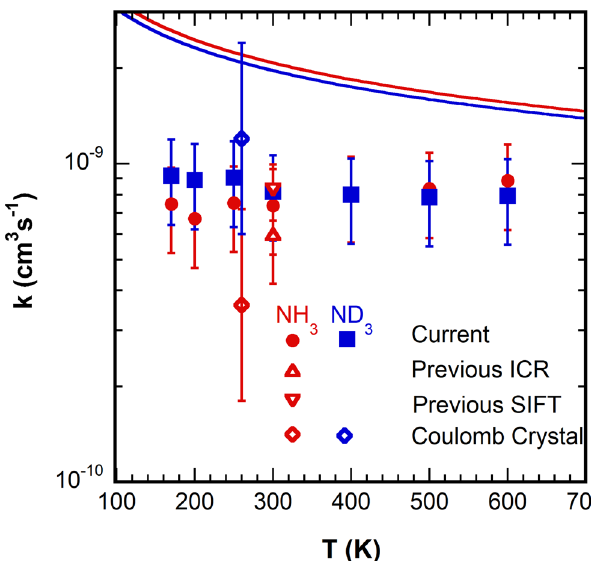
Fig. 1 Comparison of Xe + + NH 3 /ND 3 rate constants. Experimental rate constants for Xe + + NH 3 (red)/ND 3 (blue) as a function of temperature for the present work (solid circles/squares) with error bars indicating the 95% con fi dence region, as well as those previously published (open symbols): Derai et al. (up triangle, ref. 9 ) and Chau and Bowers (up triangle, ref. 10 ), Smith, Adams and co-workers (down triangle, ref. 3,4 ), Petralia et al. (diamonds, ref. 1 ). Solid curves are the parameterized capture rate constants from ref. 8 .